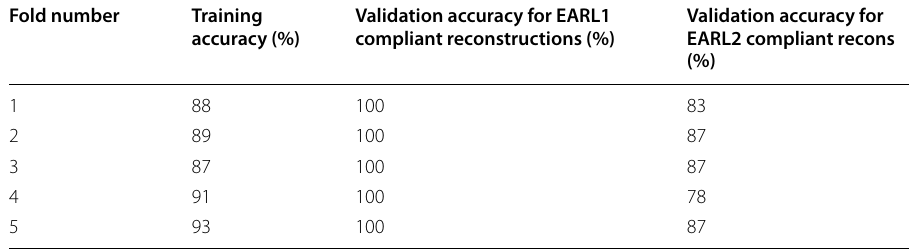
Table 3 Training and cross-validation accuracy for the second CNN trained to classify EARL1 and EARL2 compliant reconstructions Fold